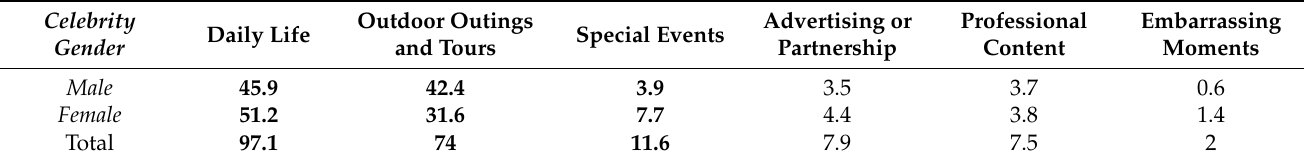
Table 3. Distribution of content themes by gender (%).